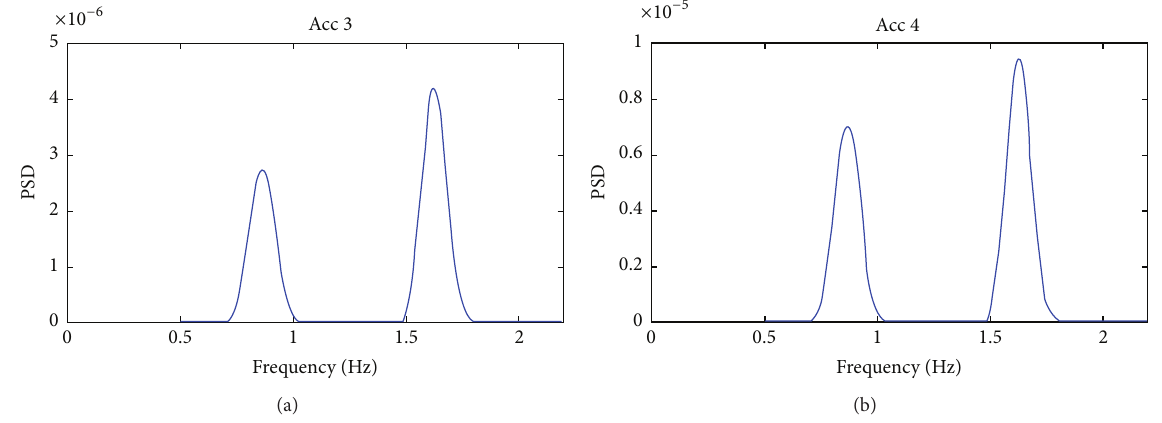
Figure 3: Acceleration of power spectral densities of points 3 and 4 in full-scale cable experiment.